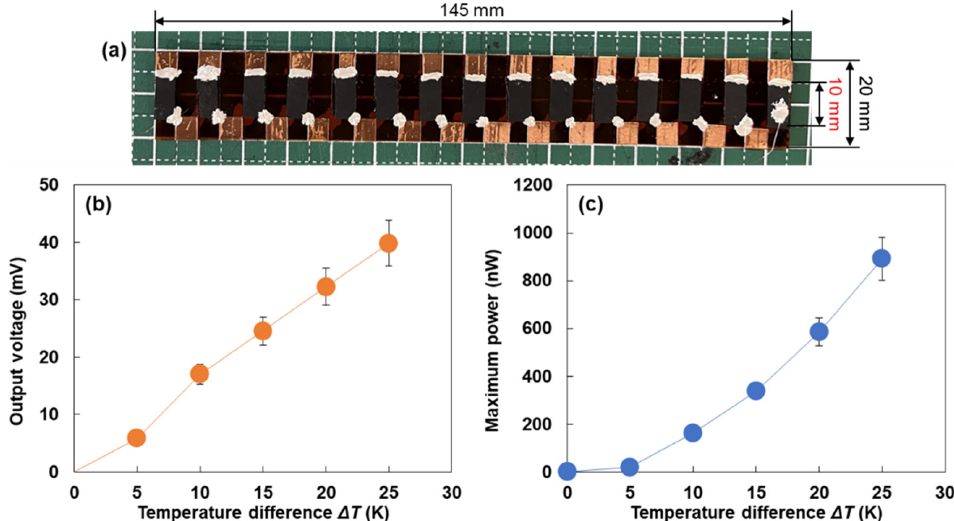
Figure 5. Performance of DFTEGs with an optimized film length and increased number of p-n pairs. ( a ) Photograph of completed DFTEG. Relationship between the temperature difference and ( b ) output voltage and ( c ) maximum power.